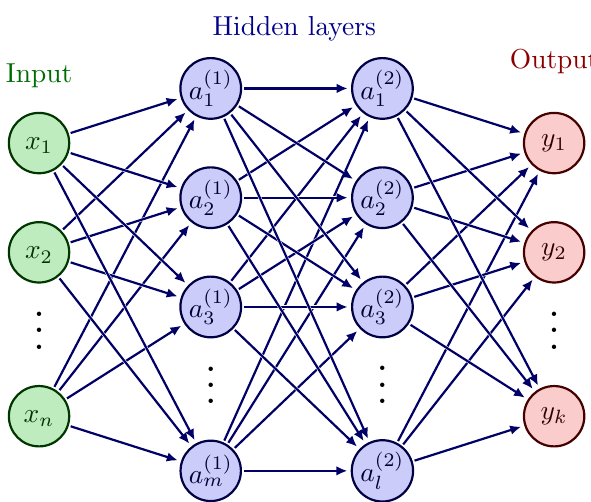
Figure 15: Graphical representation of a generic neural network (or artificial neural network ) architecture. Between the input (X) and output (Y) layers, additional neu- rons can be added, organized in hidden layers . The arrows represent the so-called activation functions , that connect the different layers of the